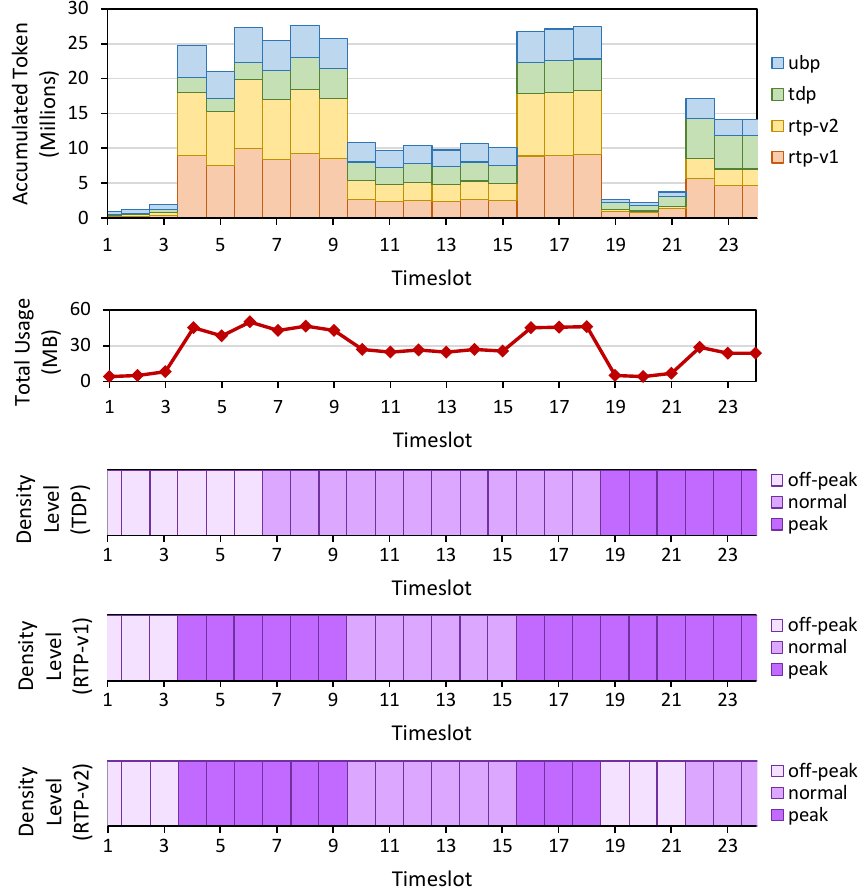
Figure 3. The experiment results for calculating the Internet bill (from ( top ) to ( bottom )) showing the accumulated token and the byte usage per timeslot for UBP, TDP, RTP-v1, and RTP-v2, and the recorded density level for TDP, RTP-v1, and